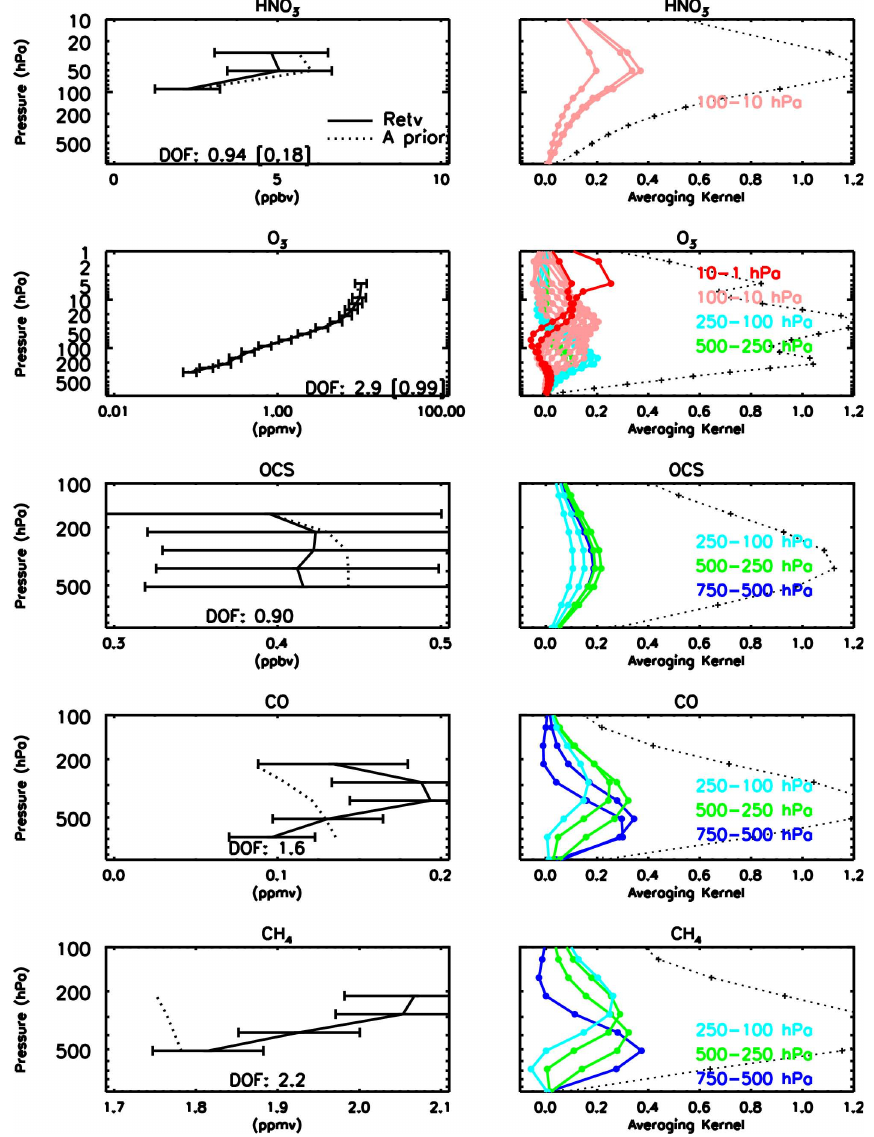
Fig. 12. Left: Tropospheric trace gas profiles and retrieval errors from the land case over the ARM SGP site. Right: Corresponding averaging kernels (in color) and sum of the rows of the averaging kernel (in